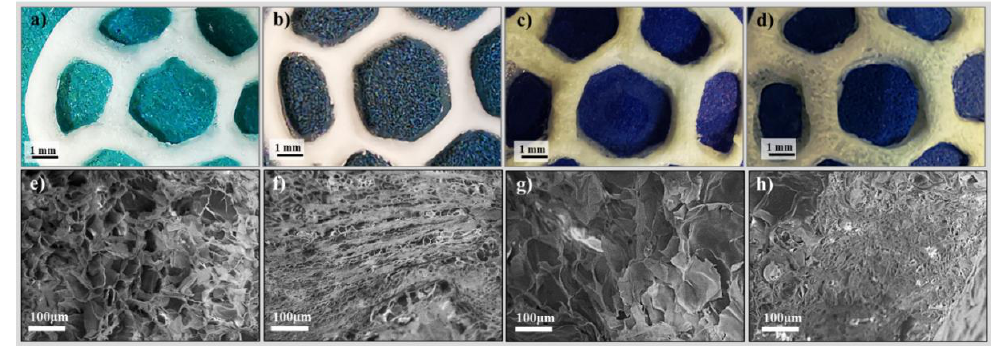
Figure 3. Representative digital photographs ( a – d ) and SEM images ( e – h ) of freeze dried 3D scaffold printed with F11 ( a,e ), F12 ( b,f ) B11 ( c,g ) and B12 ( d,h ).